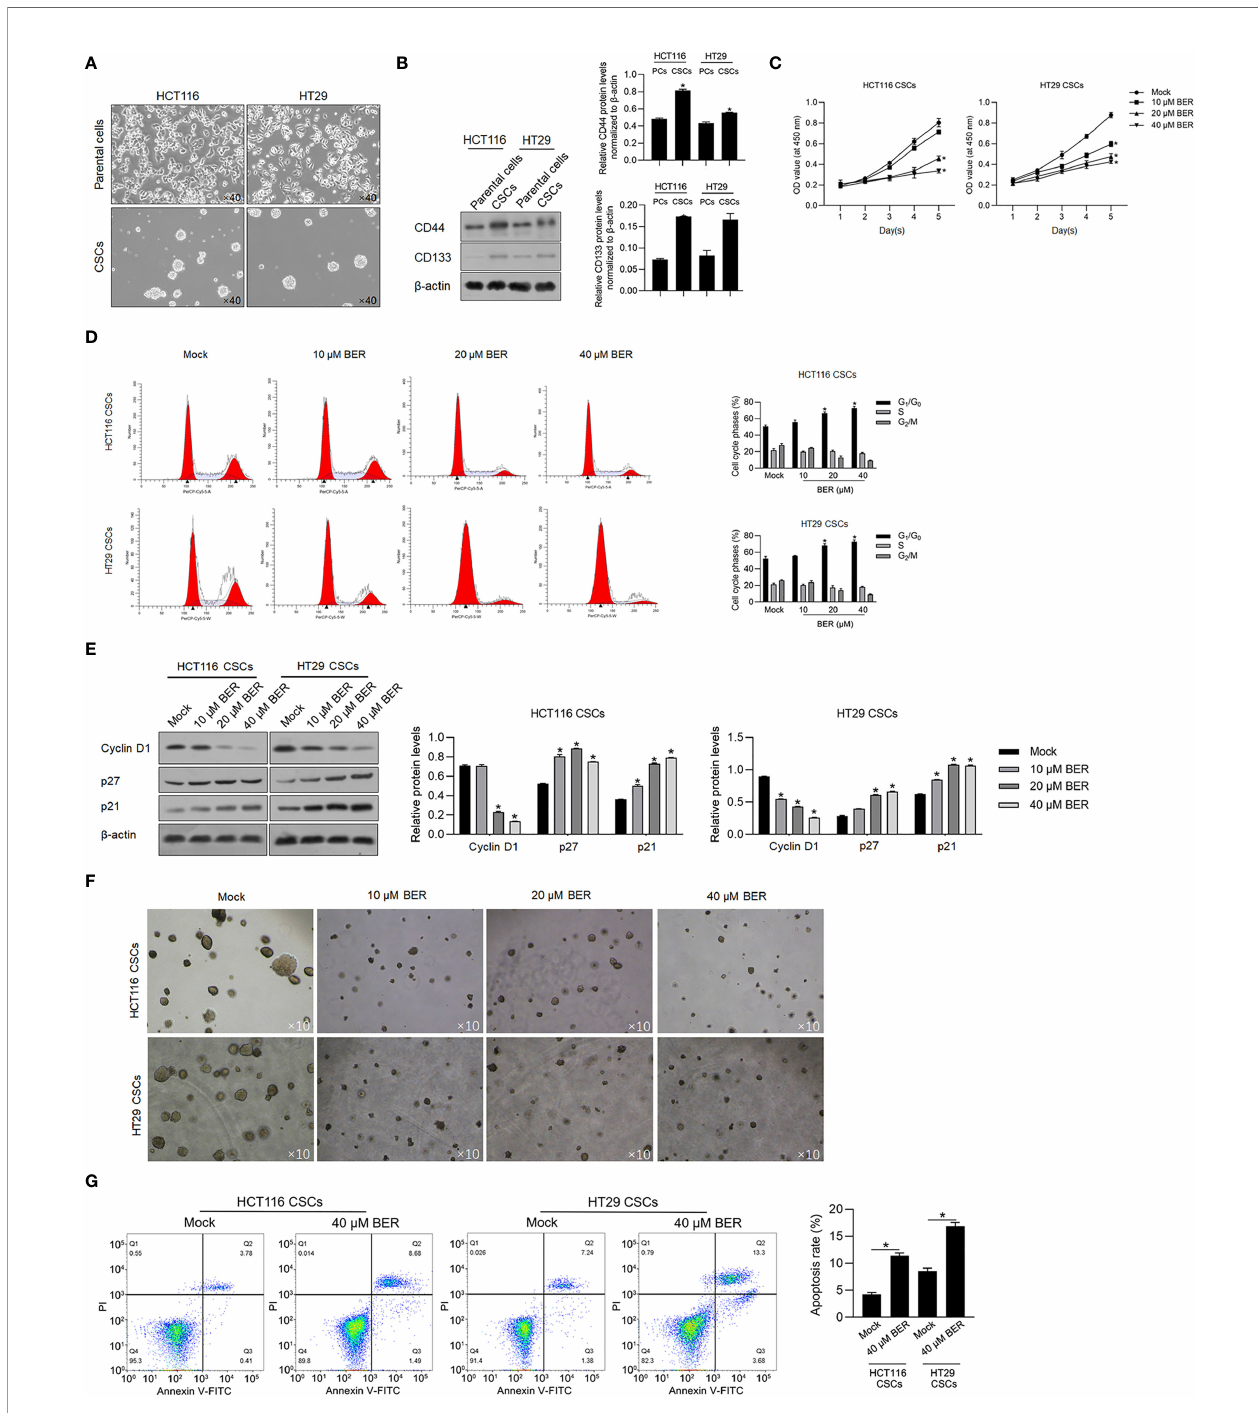
FIGURE 1 | Berberine inhibited malignancies and induced apoptosis in HCT116 and HT29 CSCs. (A) Parental HCT116 and HT29 cells were cultured in serum-free medium for 14 days, and spheres were obtained. (B) CD44 and CD133 protein levels were detected by performing the Western blot in total protein. (C) By being cocultured with 10, 20, or 40 m M of Berberine for 1 to 5 days, cell viability was measured by performing CCK-8 assay. p < 0.05, vs. mock group. By being cocultured with 10, 20, or 40 m M of Berberine for 24 h, cell cycle distribution was analyzed by performing fl ow cytometry assay (D) and p21, p27, and Cyclin D1 protein levels were measured by performing Western blot (E) . p < 0.05, vs. mock group. (F) Tumor formation ability of CSCs was measured by being cocultured with 10, 20, or 40 m M of Berberine for 14 days. (G) By being cocultured with 10, 20, or 40 m M of Berberine for 24 h, cell apoptosis was measured by performing Annexin V-FITC/PI double staining. *P < 0.05, vs. mock